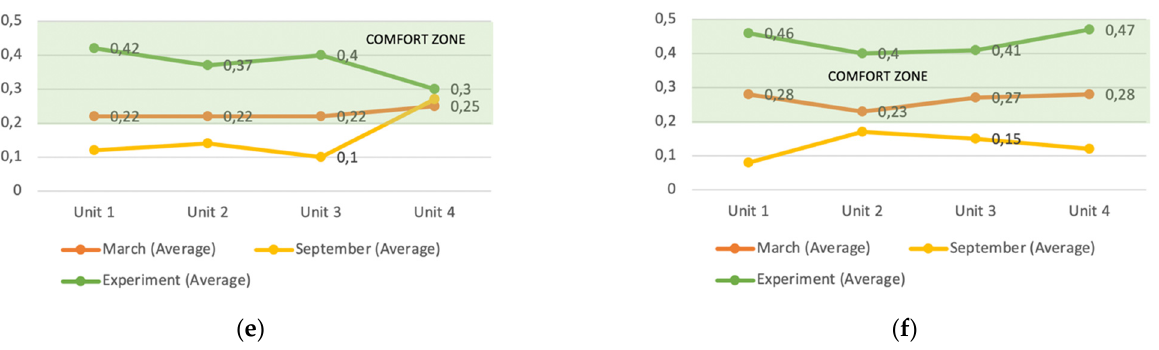
Figure 13. Comparison of the field measurement and experimental results: ( a ) 4th floor—tower A; ( b ) 10th floor—tower A; ( c ) 15th floor—tower A; ( d ) 4th floor—façade B; ( e ) 10th floor—tower B; ( f ) 15th floor—tower B.